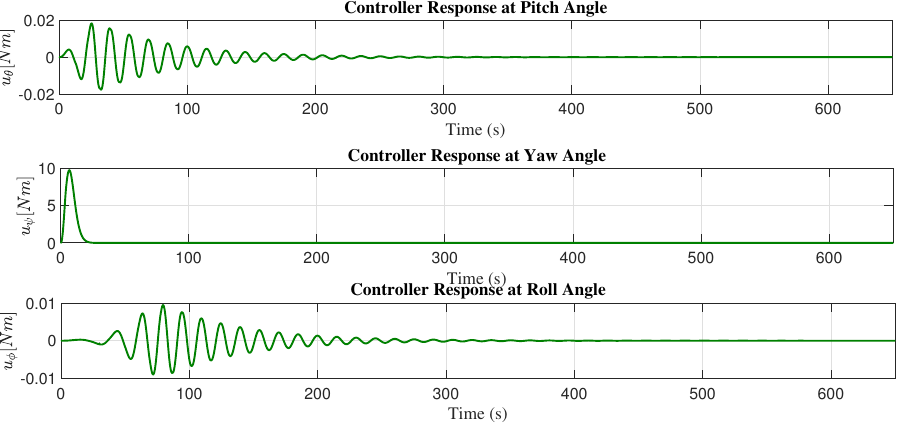
Figure 19. Controller response with MIT